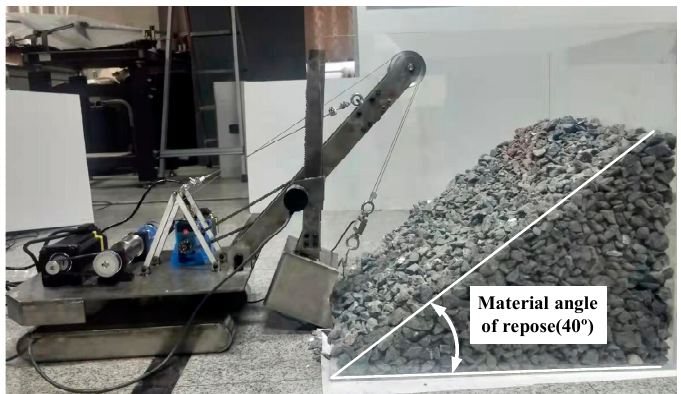
( f ) Figure 12. Comparison of simulation results under different stacking angles: ( a ) Crowd speed; ( b ) Hoist speed; ( c ) Excavating trajectory; ( d ) Excavating resistance; ( e ) Crowd power; ( f ) Hoist power. Figure 12d–f presents the trends in excavating resistance, crowd power, and hoist power with time when the ECS scale model excavates at different repose angles. It can be seen from the figure that with increasing material repose angle, the maximum excavating resistance and the maximum hoist power increase, while the maximum crowd power de- creases; the change trend of each parameter with time under different repose angles is basically the same. 4. Analysis of Test Results The degree of coincidence between the simulation results obtained based on the